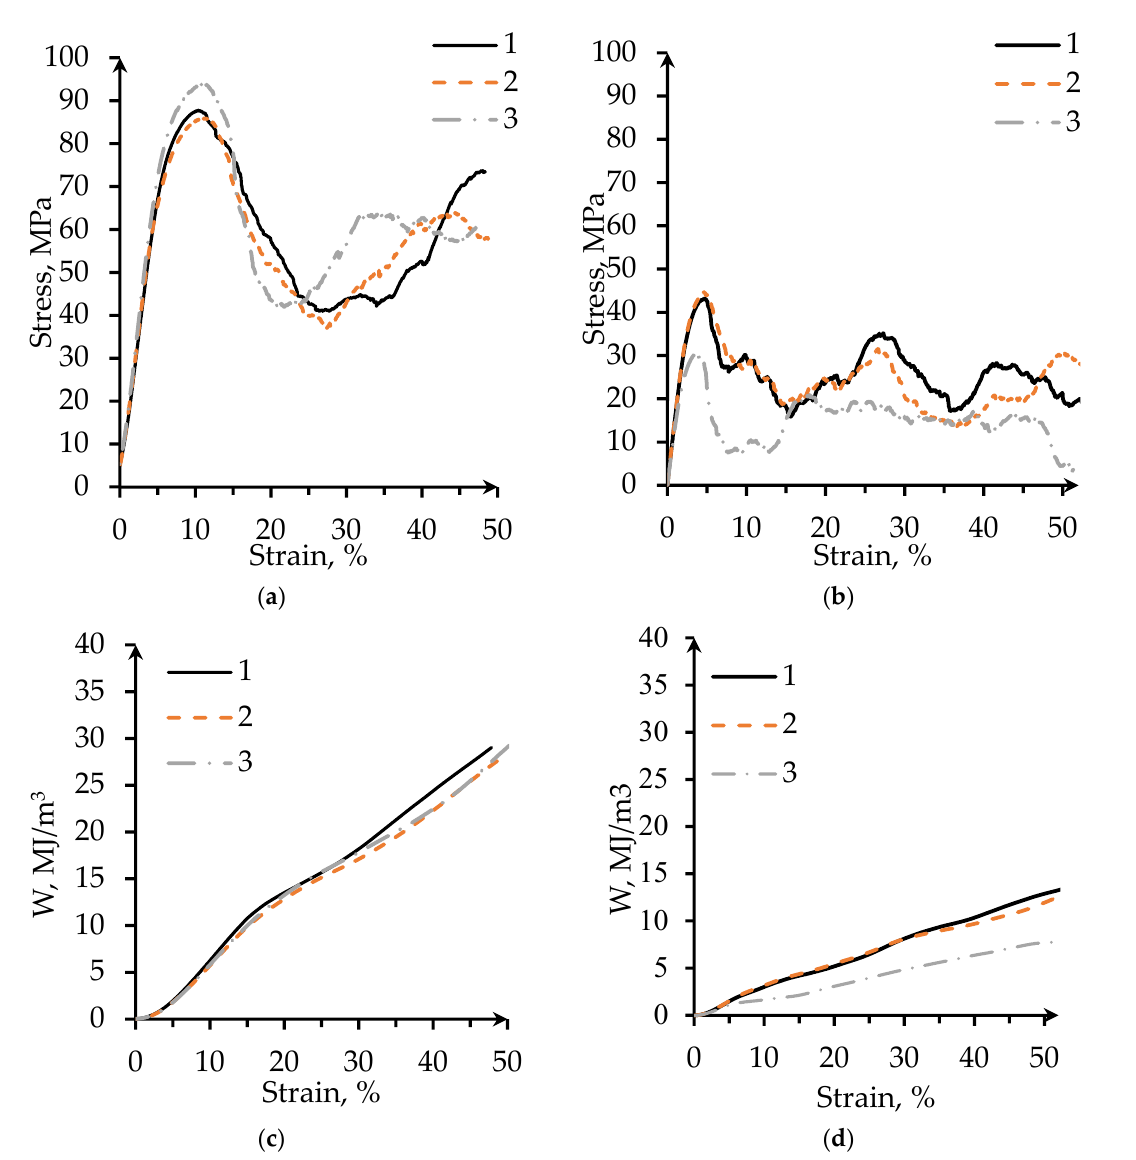
Figure 6. Compressive stress-strain curves for the gyroid samples manufactured in ( a ) MT; ( b ) WT. (Note the different y-axis scales). Energy absorption per unit volume versus strain curves for lattice samples of ( c ) MT; ( d ) WT. (Note the different y-axis scales).